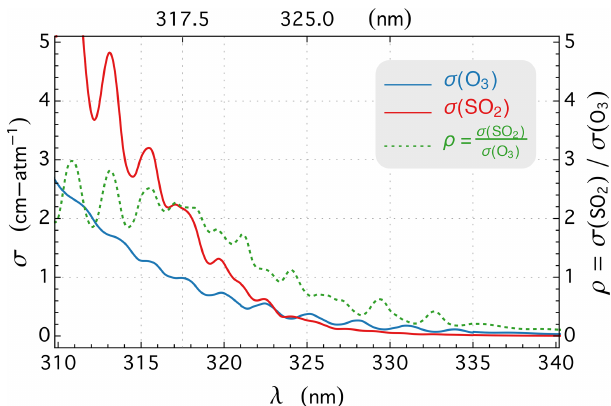
Figure 13. EPIC bandpass-averaged cross-sections σ for O 3 and SO 2 at 280K and their ratio, ρ = σ ( SO 2 )/σ ( O 3 )